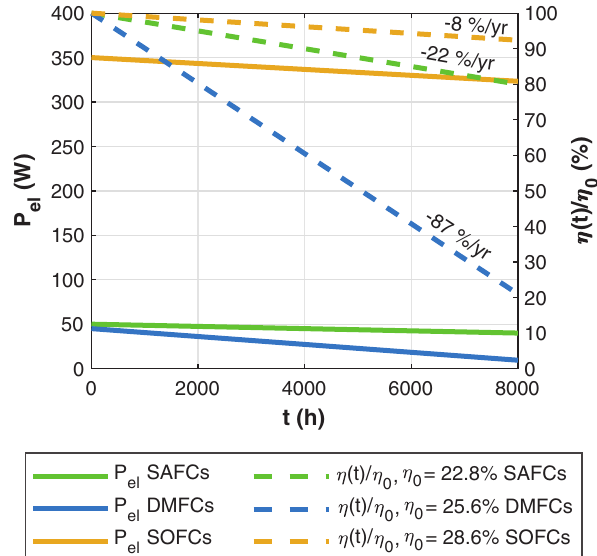
Figure 6. Power and efficiency decay with time of FCs.